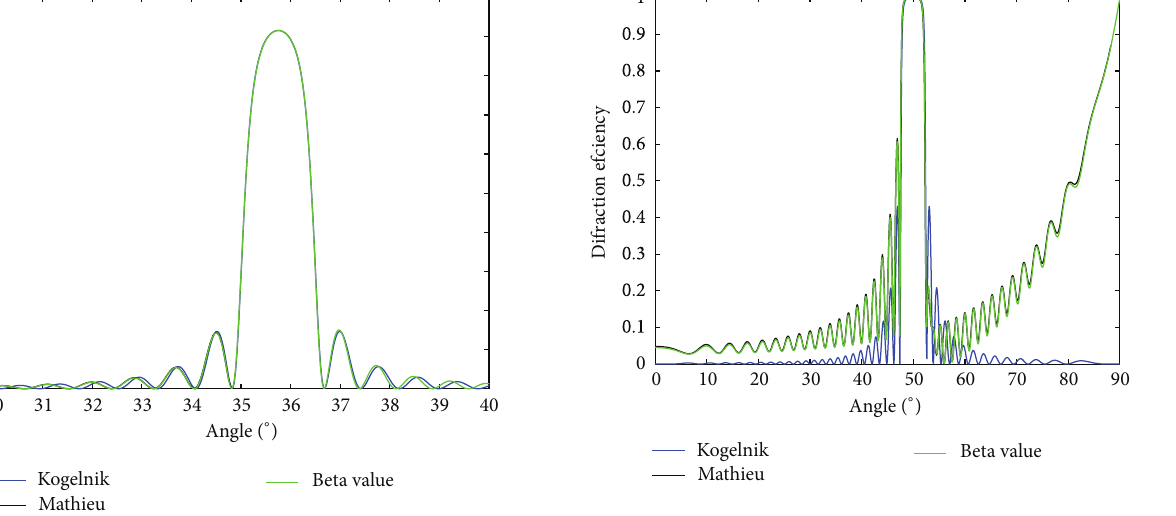
Figure 5: Diffraction efficiency of a reflection grating index- matched with thickness of 26 𝜇 m, spatial frequency of 3800 lines/mm, average refractive index 𝑛 index modulation of 0.012.